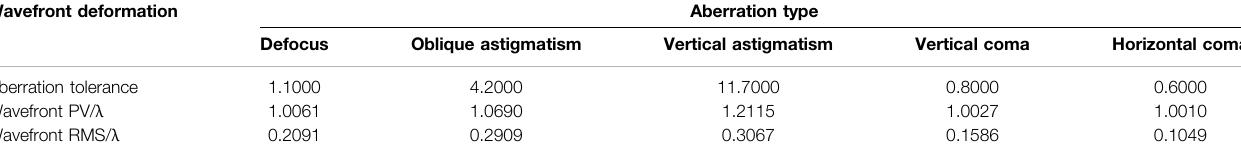
TABLE 2 | Tolerance of aberration strength for common aberrations and the wavefront